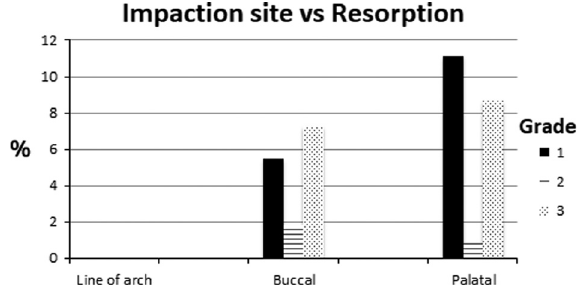
Figure 5. Overlap by sectors correlated to severity of resorption by